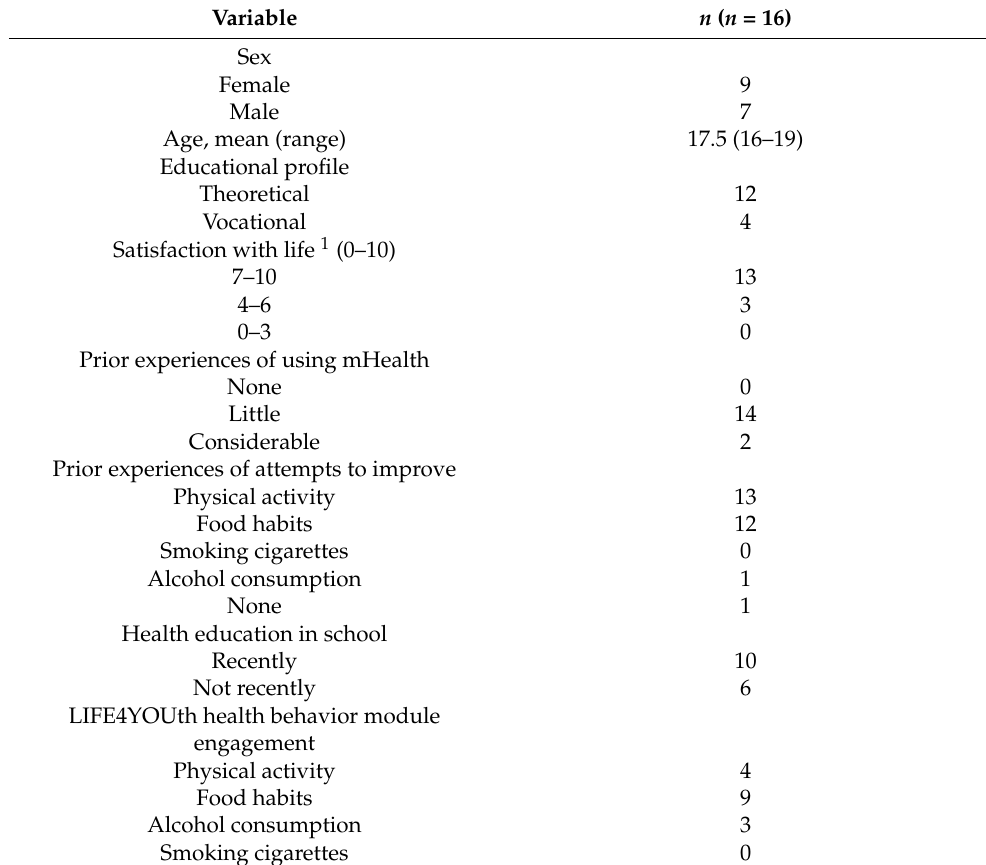
Table 2. Informant characteristics and health behavior modules addressed in